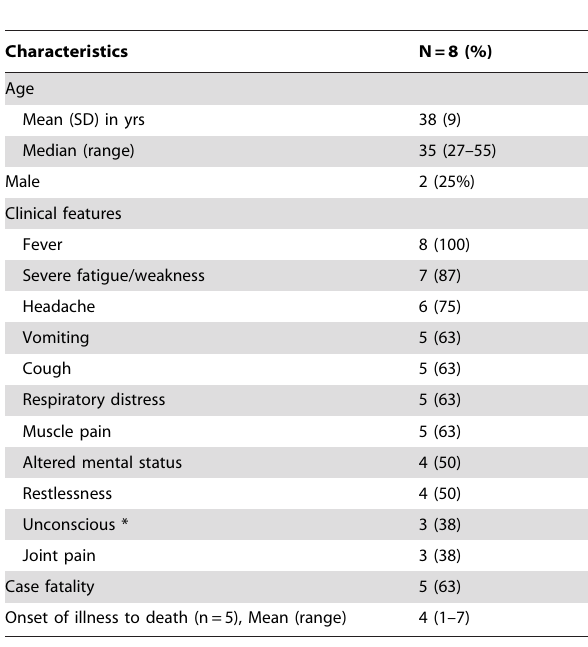
Table 1. Characteristics of Nipah case-patients, Sadar Upazila, Kushtia District, Bangladesh, March-April 2007.